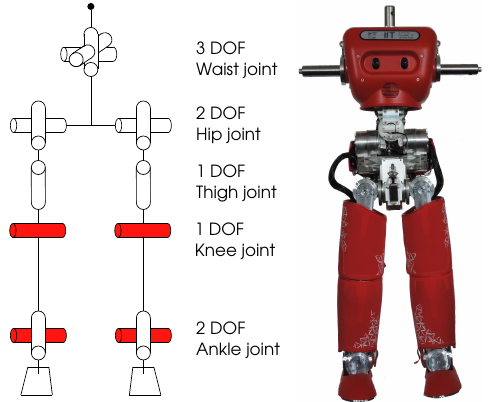
Figure 1. The HeiCub (iCub of Heidelberg University) humanoid robot. In red, the series elastic actuators, which are not considered in the context of this work.